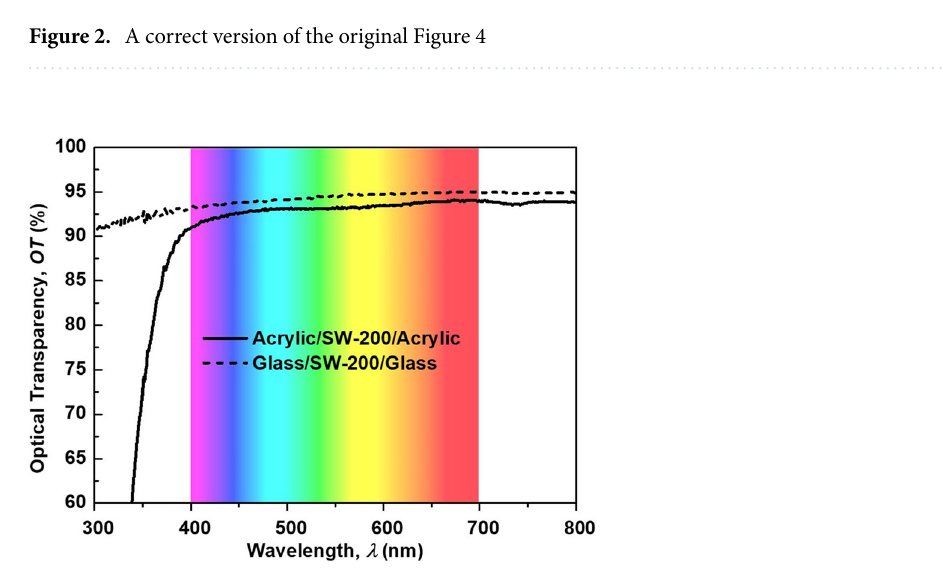
Figure 3. A correct version of the original Figure